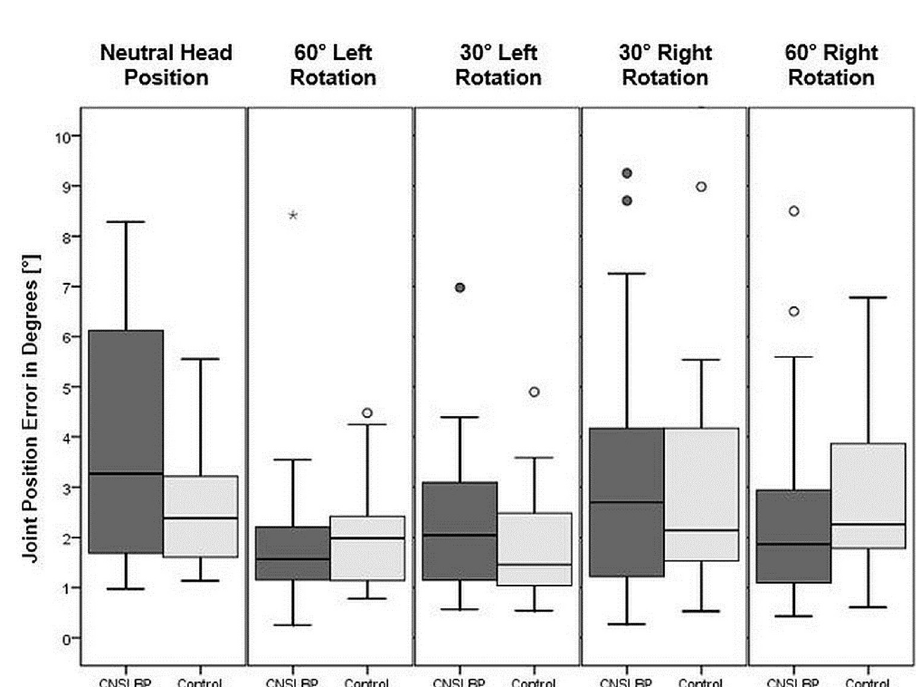
Fig 3. Boxplots of position data of the 5 different positions. Boxplots of the medians and Interquartile Range of the JRE of five different positions. Outliers are expressed as � and